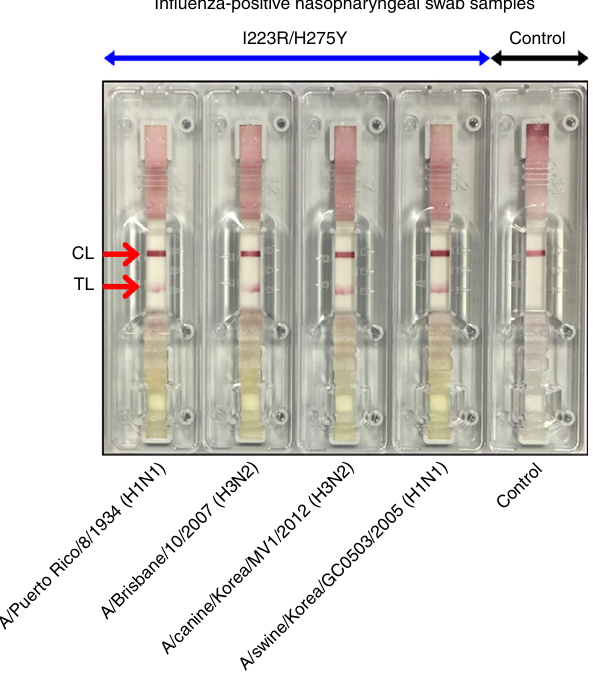
Fig. 9 LFA of I223R/H275Y in fl uenza viruses in human nasal fl uid samples using A4. Optical images of A4-based lateral fl ow systems after detection of in fl uenza-positive nasopharyngeal swab samples in the absence or presence of I223R/H275Y in fl uenza viruses (A/Puerto Rico/8/ 1934 (H1N1), A/Brisbane/10/2007 (H3N2), A/swine/Korea/GC0503/ 2005 (H1N1), and A/canine/Korea/MV1/2012